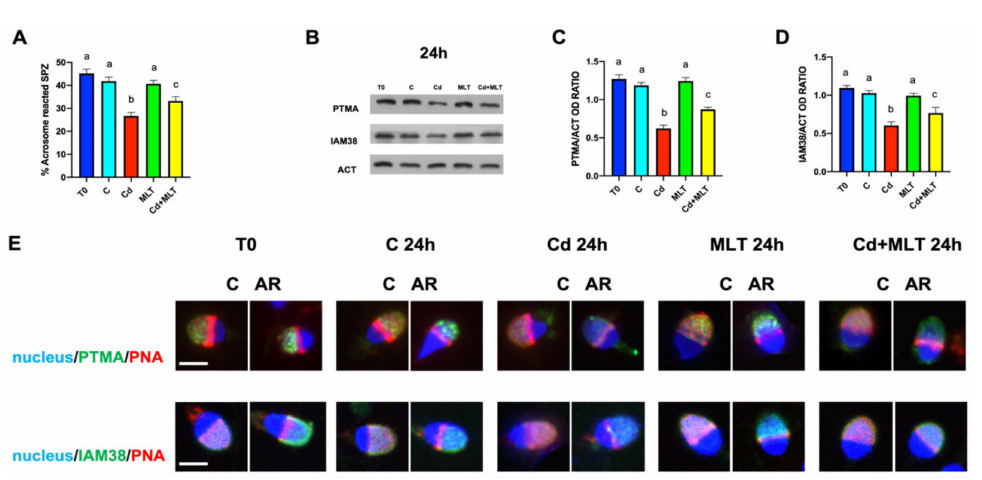
Figure 6. Acrosome reaction, WB, and IF analysis of PTMA and IAM38 of sperm samples incubated with Cd and/or MLT for 24 h. ( A ): Histogram showing the percentage of acrosome reacted SPZ induced by progesterone. ( B ): WB analysis showing PTMA (15 kDa), IAM38 (38 kDa), and β -actin (42 kDa) protein levels in SPZ treated with Cd and/or MLT. ( C , D ): Histograms showing the relative protein levels of PTMA ( C ) and IAM38 ( D ), respectively. Data were normalized with β -actin and reported as OD ratio. Values are expressed as means ± SEM from 15 samples divided into the five groups, including the initial control (T0). a vs. b p < 0.001 a vs. c p < 0.05; b vs. c p < 0.01. ( E ): IF analysis of PTMA (green, upper panel) and IAM38 (green, lower panel) in SPZ treated with Cd and/or MLT for 24 h. Red represents α -tubulin in the upper and middle panels, and acrosome, marked with PNA lectin, in the lower panel. Slides were counterstained with DAPI-fluorescent nuclear staining (blue). Scale bars represent 5 µ